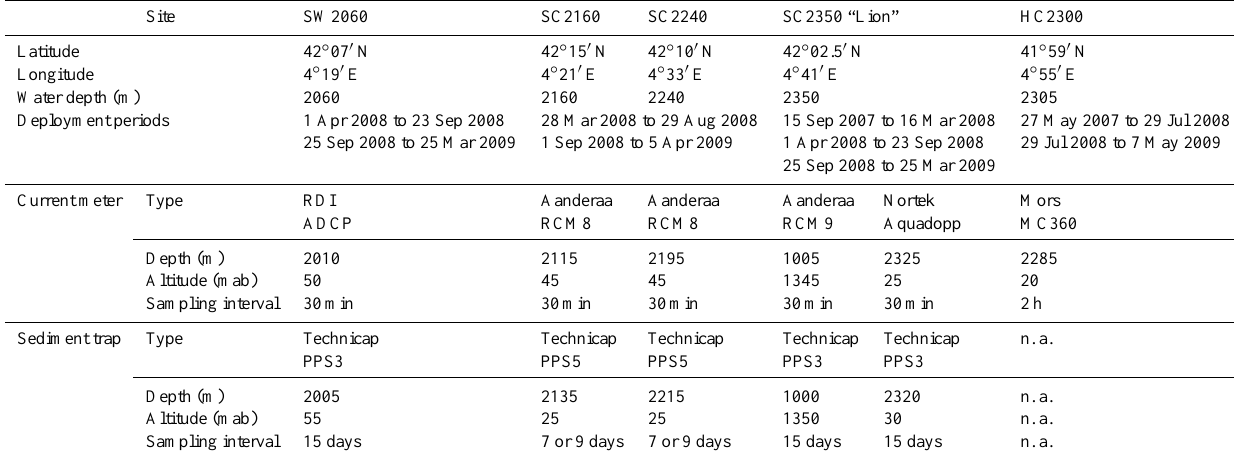
Table 1. Location, deployment periods, instrument type and placement within each line, and sampling rates of current meters and sediment traps in the mooring lines considered in this paper.